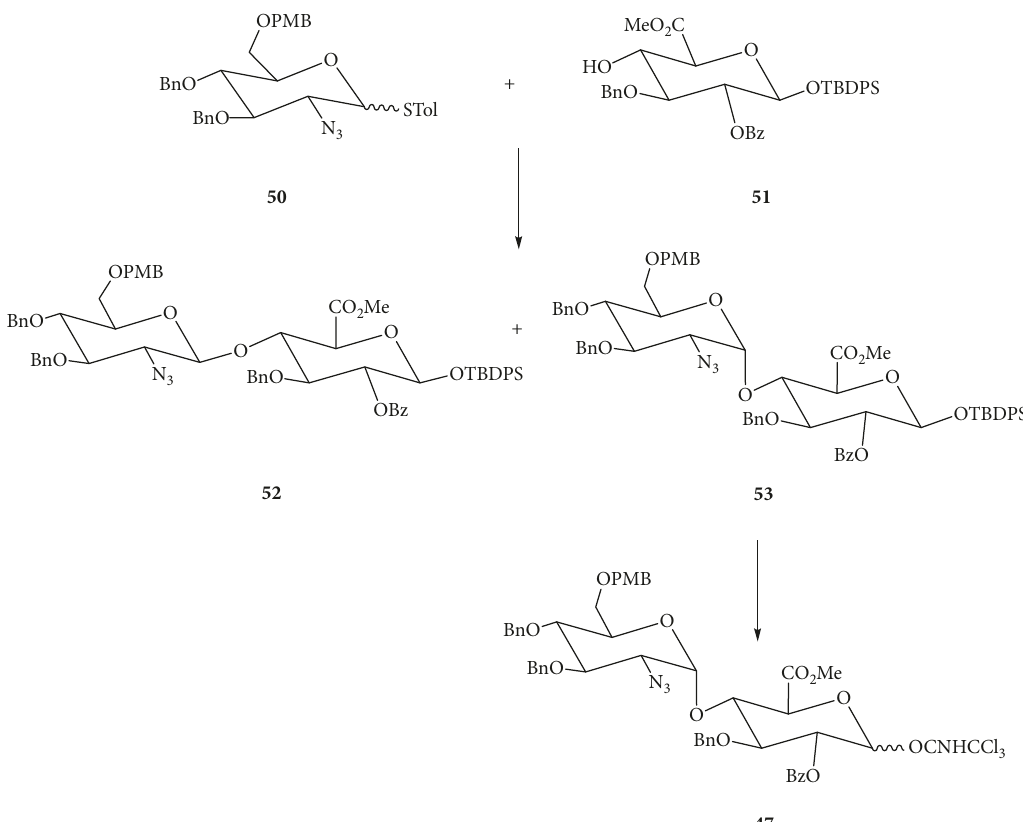
Scheme 16: Alchemia’s strategy for the synthesis of the ED disaccharide fragment.